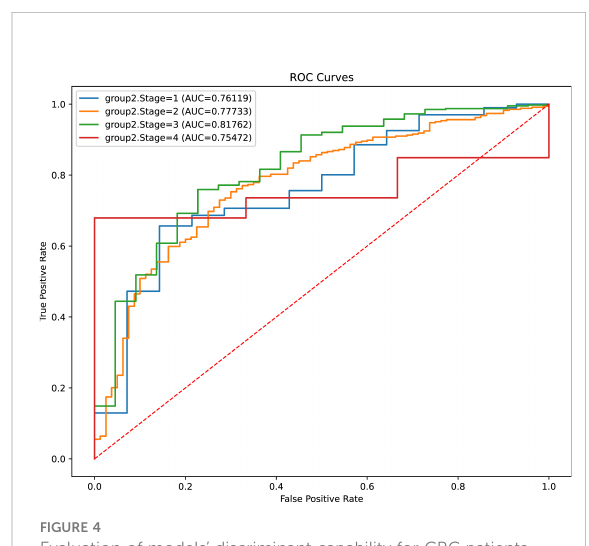
FIGURE 4 Evaluation of models ’ discriminant capability for CRC patients with different clinical stage. ROC, receiver operating characteristic; AUC, area under